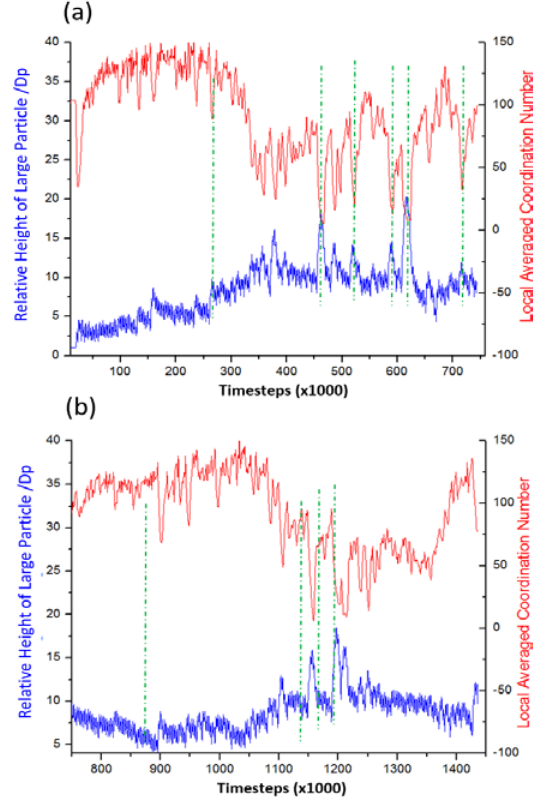
Fig. 2 . Time evolution of the relative height of large particles and the local averaged coordination number (LACN). Vibration frequency: 20 Hz; vibration amplitude: 10 mm. Two figures are shown: (a) from 0 to 570k timesteps; and (b) from 750k to 1450k